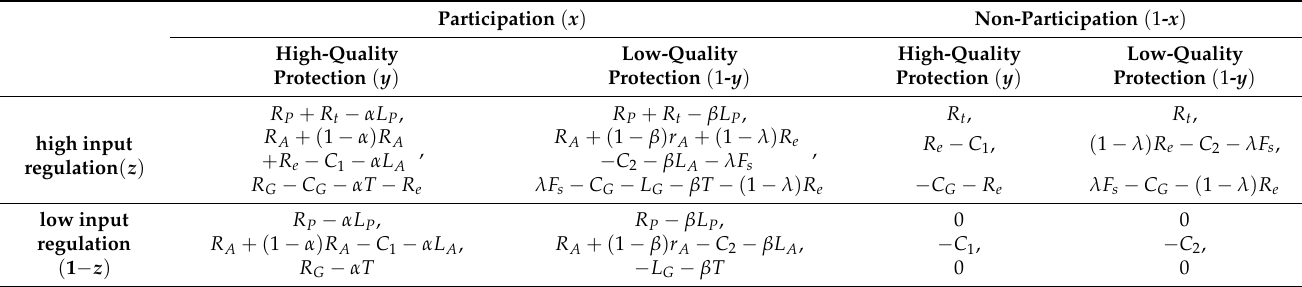
Table 2. Matrix of benefits for game